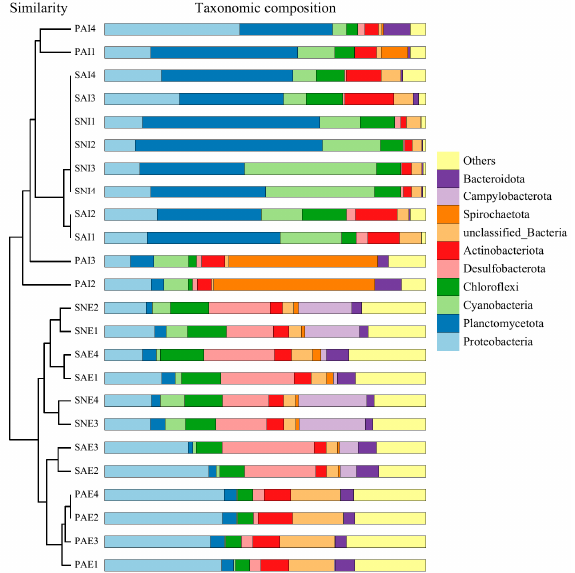
Figure 5. UPGMA tree showing the similarity of bacterial community structures among the different samples. The gut contents and surrounding sediments of S. australe, P. arcuatum, and S. nudus are, respectively, marked as SAI, PAI, SNI, SAE, PAE, and SNE.